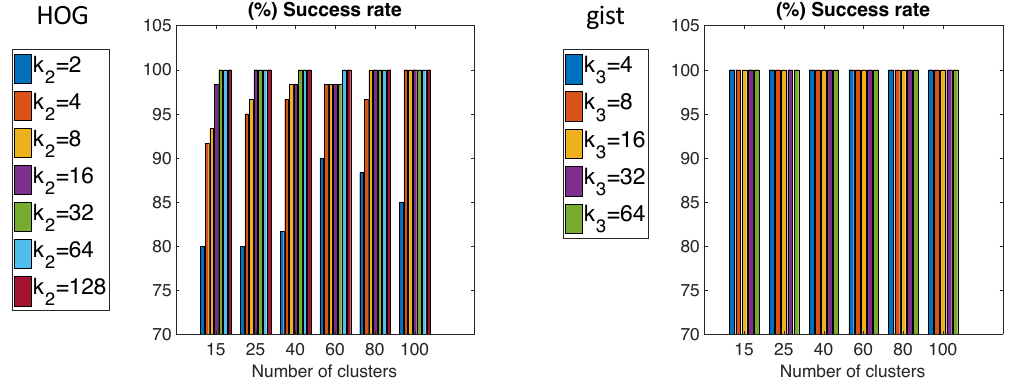
Figure 19. Percentage of success to detect the correct environment between Freiburg and Saarbrücken with FS, HOG, and gist used to describe the representatives of the clusters and the test images: percentage of success vs. number of